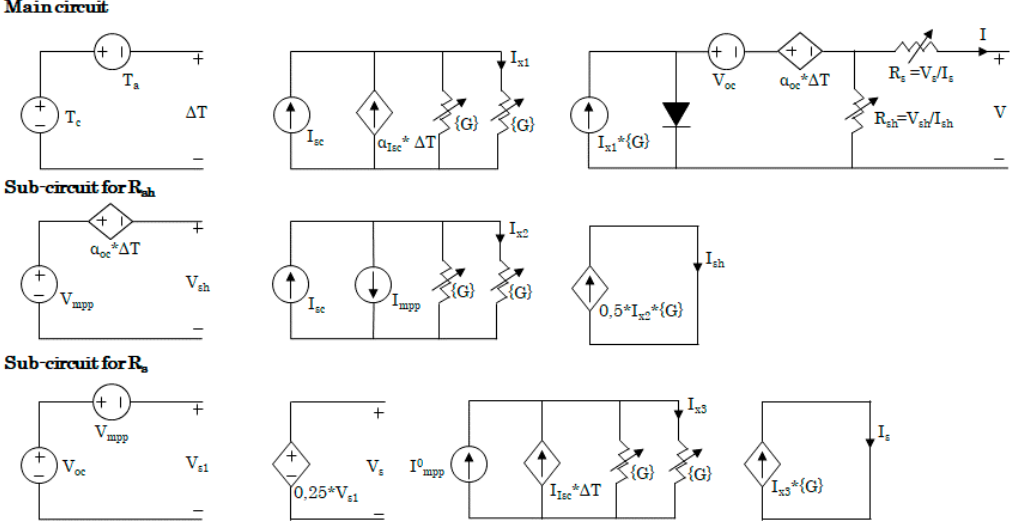
Figure 2. Single cell equivalent electrical model.